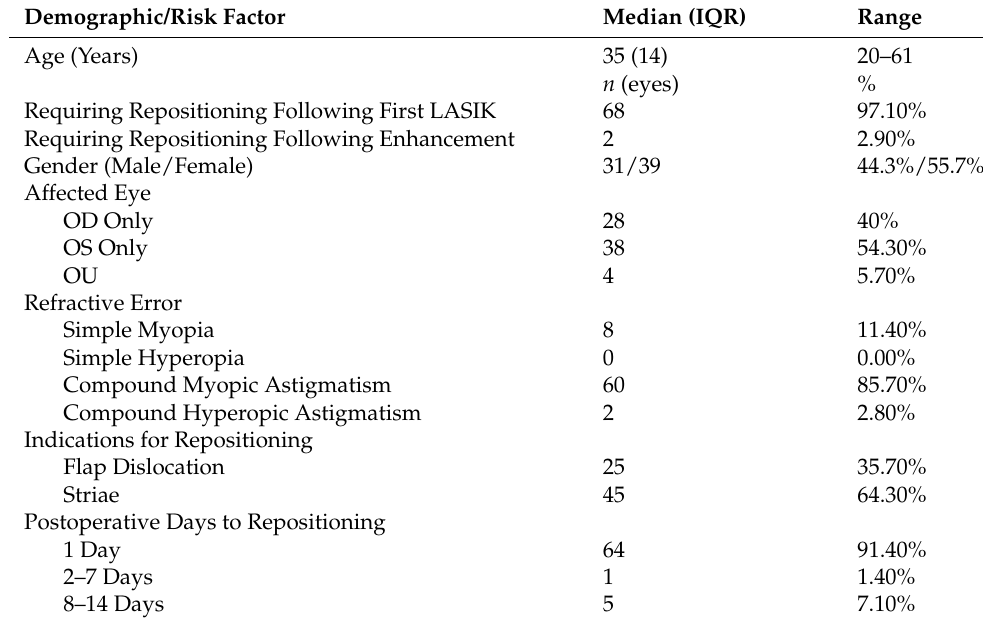
Table 1. Demographics and risk factors of patients undergoing flap repositioning following LASIK.